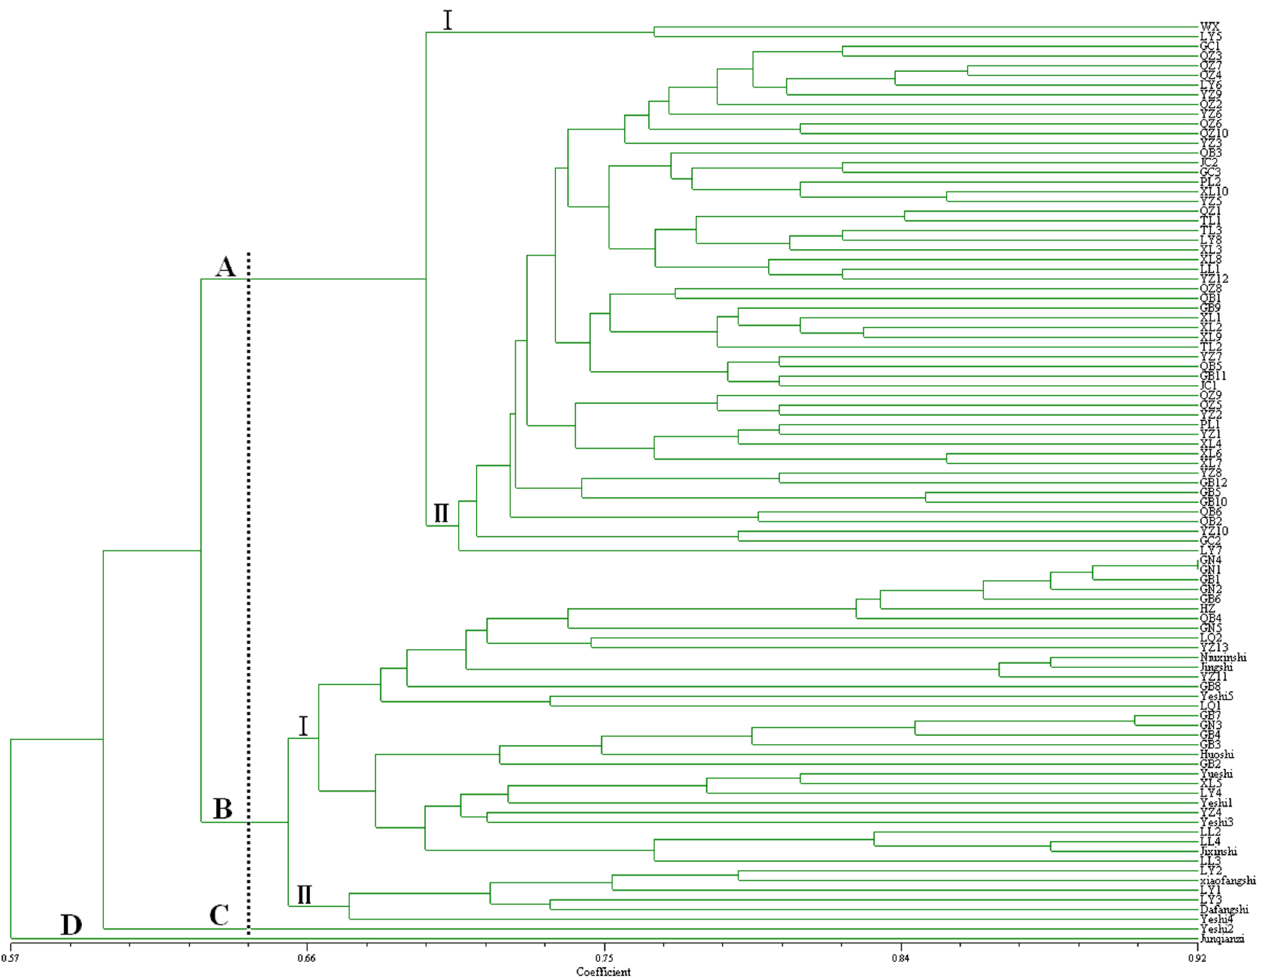
Fig 3. UPGMA dendrogram of the accessions of 95 diospyros germplasms based on SSR molecular markers.